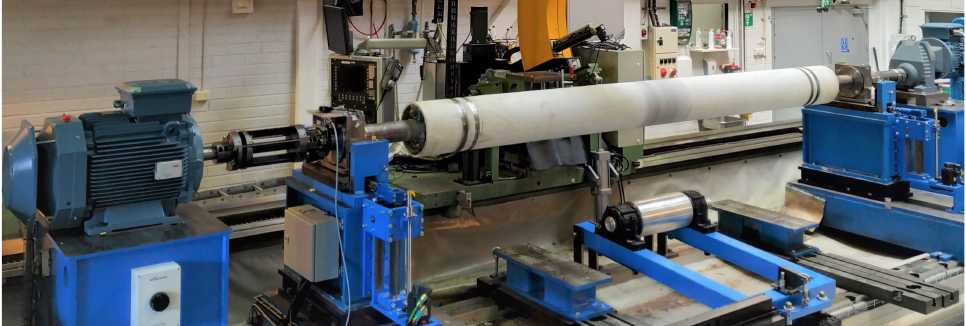
Figure 4. The complete measurement